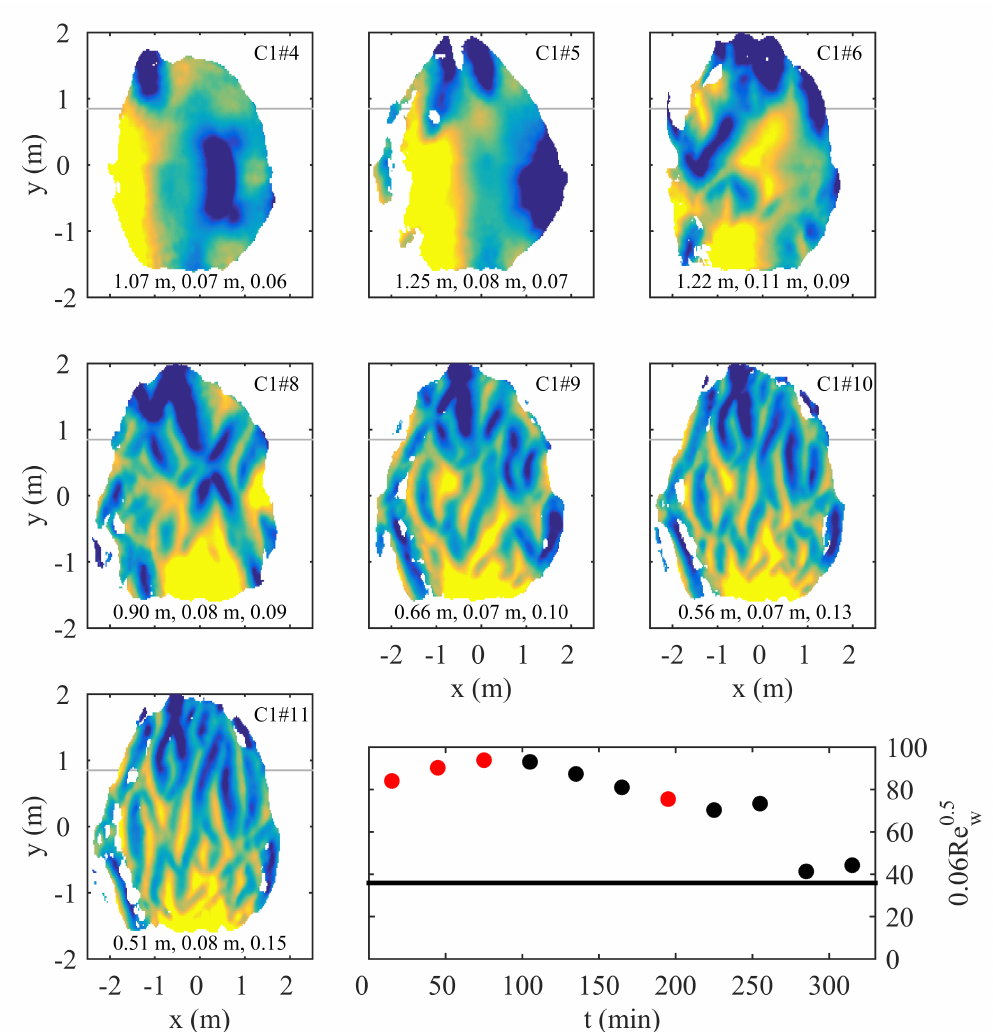
Figure 9. Bed elevation models for selected runs in test C1. For additional explanation,